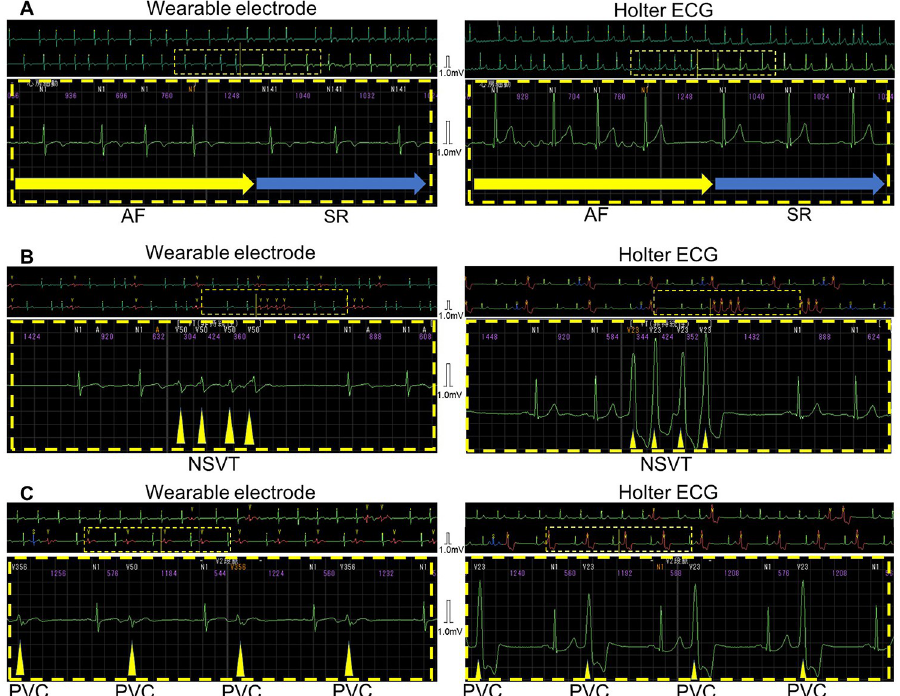
Fig 4. The comparison of wave patterns of arrhythmia between wearable electrodes embedded in undershirts and Holter ECG. (A) atrial fibrillation, (B) non-sustained ventricular tachycardia, and (C) premature ventricular contractions of Lown‘s grade > II. Abbreviations: AF, atrial fibrillation; SR, sinus rhythm; NSVT, non-sustained ventricular tachycardia; PVC, premature ventricular contractions; ECG, electrocardiogram.